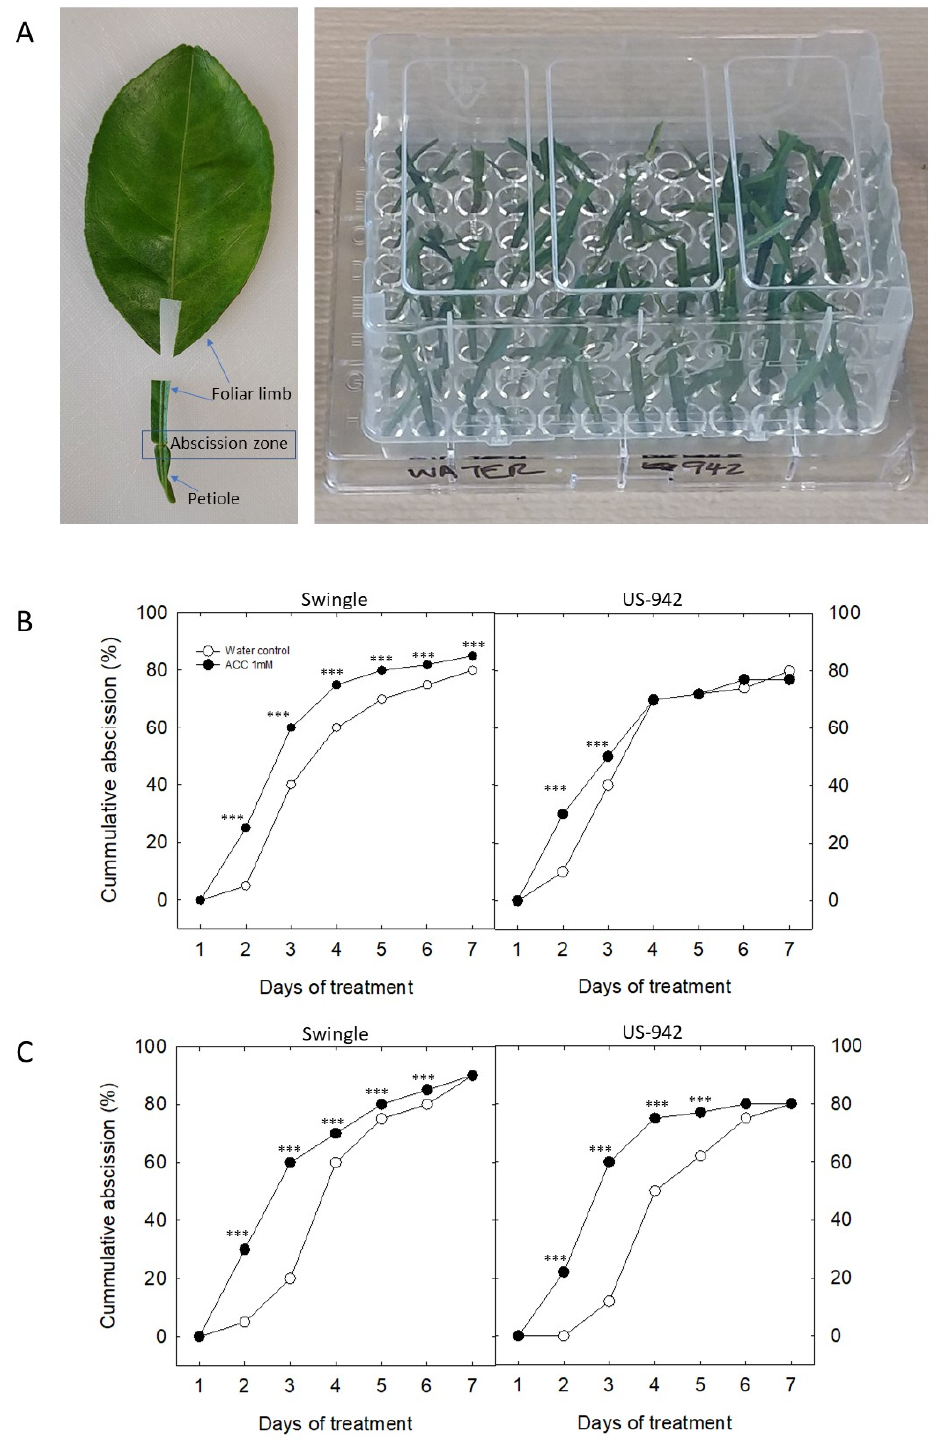
Figure 4. In vitro assessment of leaf explant abscission in leaves from Valencia and Hamlin scions grafted on Swingle and US-942 rootstocks. ( A ), experimental setup, showing the excised petiole containing the abscission zone as it was used in the assay performed in 96-well ELISA plates con- taining water or a 1 µM solution of ACC. ( B ), cumulative abscission in Hamlin and ( C ), cumulative abscission in Valencia. Asterisks *** indicate p -value is significant at 0.1% according to Tukey-Kra- mer.